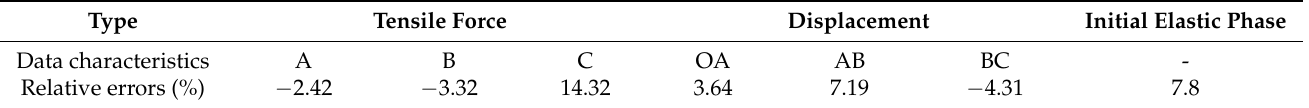
Table 6. Relative errors (%) of data characteristics in Test 1 and FEM-0.